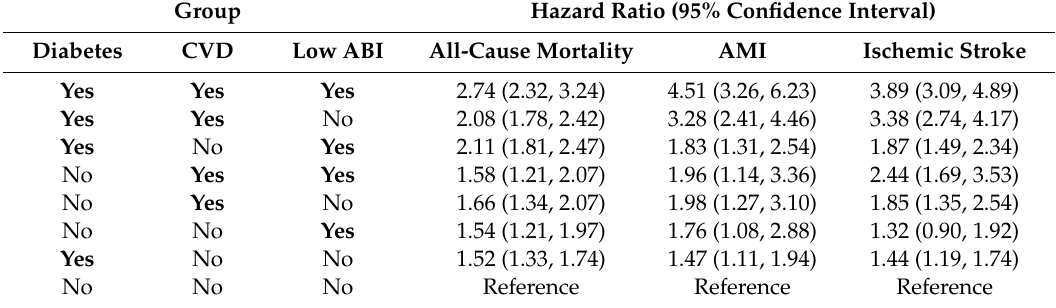
Table A2. Unadjusted hazard ratios (95% confidence intervals) for all-cause mortality, acute myocardial infarction, and ischemic stroke, by groups.